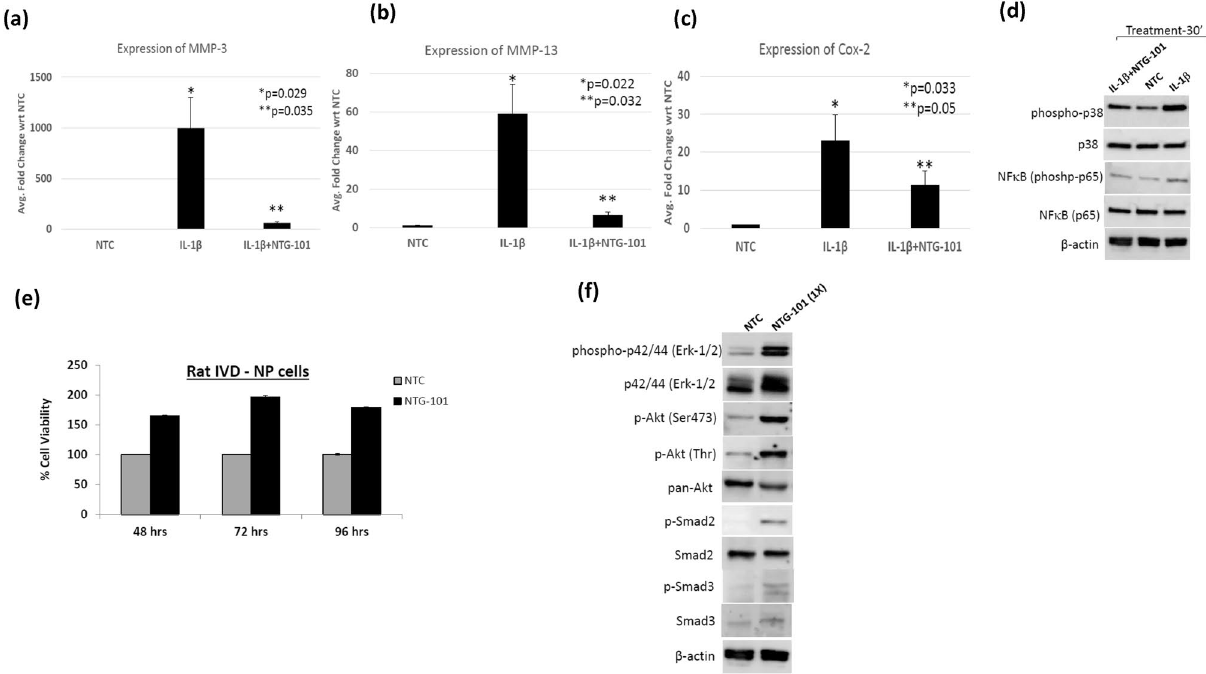
Figure 6. Panel shows histograms representing gene expression of ( a ) MMP-3, ( b ) MMP-13 and ( c ) Cox-2 in no treatment controls (NTC), rats NP cells treated with pro-inflammatory cytokine, IL-1β (10 ng/ml) alone or in the presence of NTG-101 for 24 h as determined using qPCR analysis (*p-value for IL-1β vs. NTC, **p p-value for (IL-1β + NTG-101) vs. IL-1β); ( d ) Western blot showing phosphorylation of p38 and p65 sub-unit of NFκB complex, total protein expression of p38, p65-NFκB and β-actin as loading control in cell lysates obtained from no treatment controls (NTC), cells treated with IL-1β (10 ng/ml) alone or in the in the presence of NTG-101 for 24 h; ( e ) Cell viability in rat IVD-NP cells treated with NTG-101 for 48–96 h with respect to no treatment controls (NTC); ( f ) Western blots showing increase in phosphorylation of p42/44, also known as Erk-1/2 (Thr202/Tyr204), Akt (Ser473), Akt (Thr308), Smad-2 (Ser465/467) and Smad-3 (Ser423/425) in whole cell lysates prepared from rat IVD-NP cells treated with NTG-101 for 30 min as compared to untreated, no treatment control cell lysates. Western blots of non-phosphorylated Erk-1/2, pan-Akt, Smad-2 and Smad-3 total protein served as a control for change in expression of protein in treated and control cells. β-actin served as loading control for Western blotting